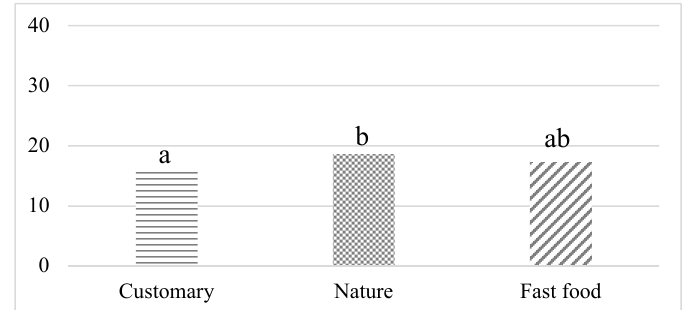
Figure 6. Relative share of vegetarian dishes of all lunch dish choices during the weeks with ‘customary ambience’, ‘nature ambience’ and ‘fast food ambience’. Data from all customers who purchased lunch during the study weeks (‘customary ambience’ week = 1610, ‘nature ambience week’ = 1714, ‘fast food ambience’ week = 1805). Different letters above the bars indicate statistically significant difference ( p ≤ 0.1) between the study